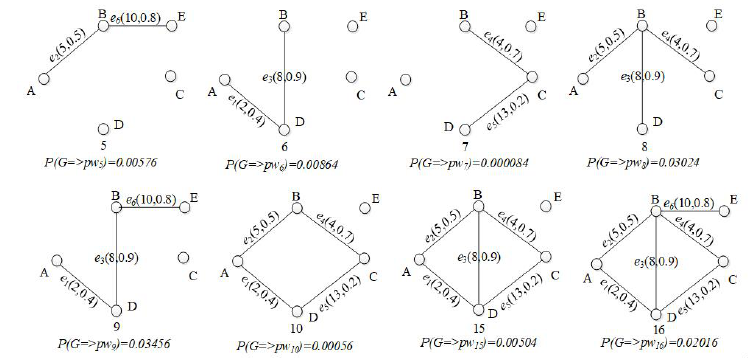
Figure 2. Some possible world graphs of G 1